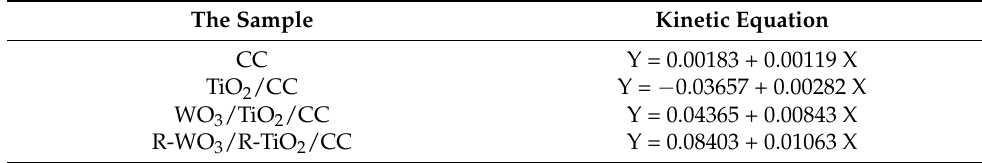
Table 1. Equation of quasi-first-order dynamics.